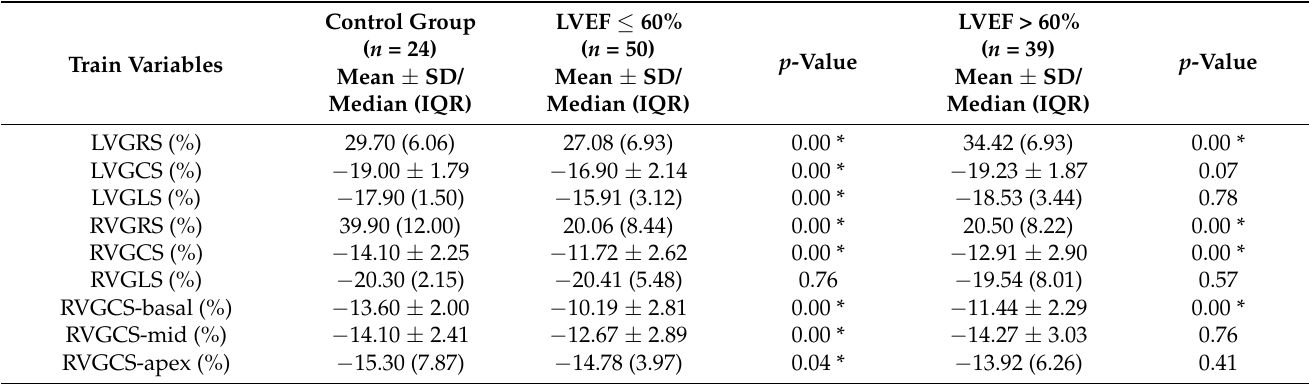
Table 5. Comparison of RV and LV strain values in normal and abnormal groups based on LVEF with the control group.